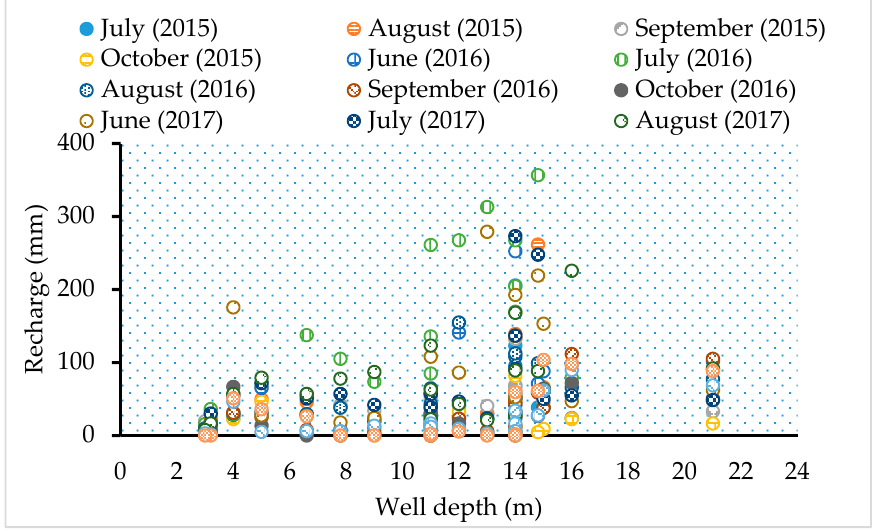
Figure 5. Monthly shallow groundwater recharges (2015 to 2017) for all monitoring wells. The values of recharge indicated were for the specific monitoring wells (point value).